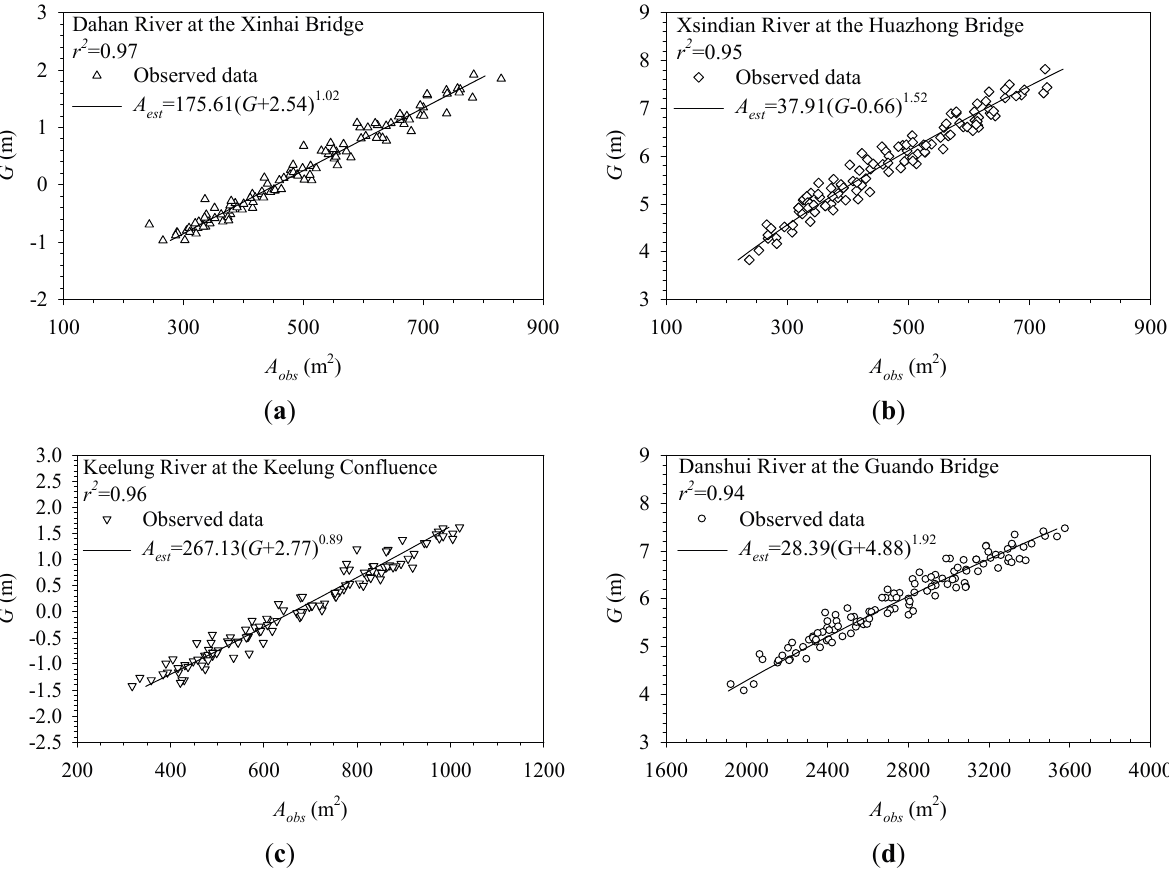
Figure 5. Relation of water level and cross-sectional area in the gauging station network during calibration phase: ( a ) Xinhai Bridge; ( b ) Huazhong Bridge; ( c ) Keelung Confluence; ( d ) Guando